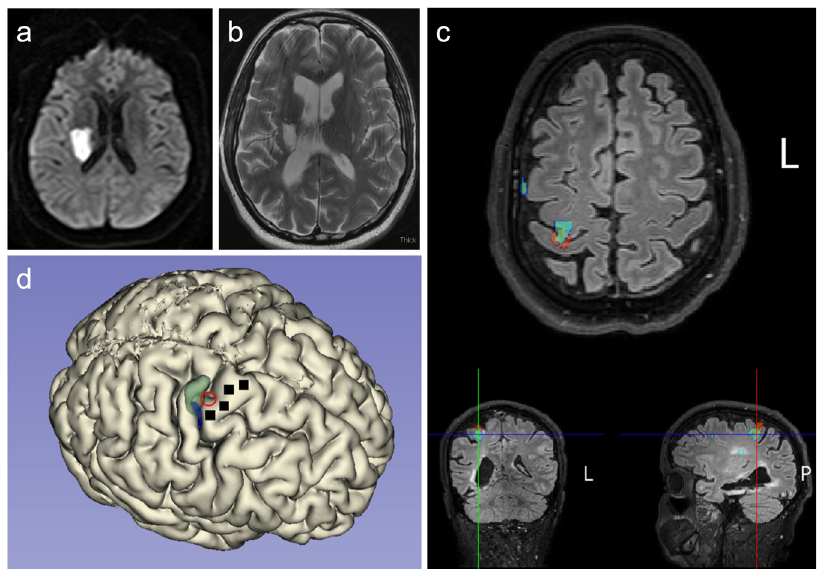
Fig. 3 Neuroimaging results. Diffusion sequence when the acute stroke occurred; diffusion restriction is evident in the right lentiform nucleus and adjacent white matter ( a ). T2-weighted MRI two years later shows areas of encephalomalacia and relative ventriculomegaly ( b ). Functional neuroimaging revealed a hot spot of activation, indicated by a red circle, in the depth of the central sulcus along the ‘ hand knob ’ area of the precentral gyrus ( c ). A three-dimensional reconstruction of the participant ’ s cortical surface derived from MRI with imagined left hand movement centroid of activity indicated by the red circle ( d ). Green shading indicates an area responsive to sensory stimulation of the left hand. Black squares indicate microelectrode